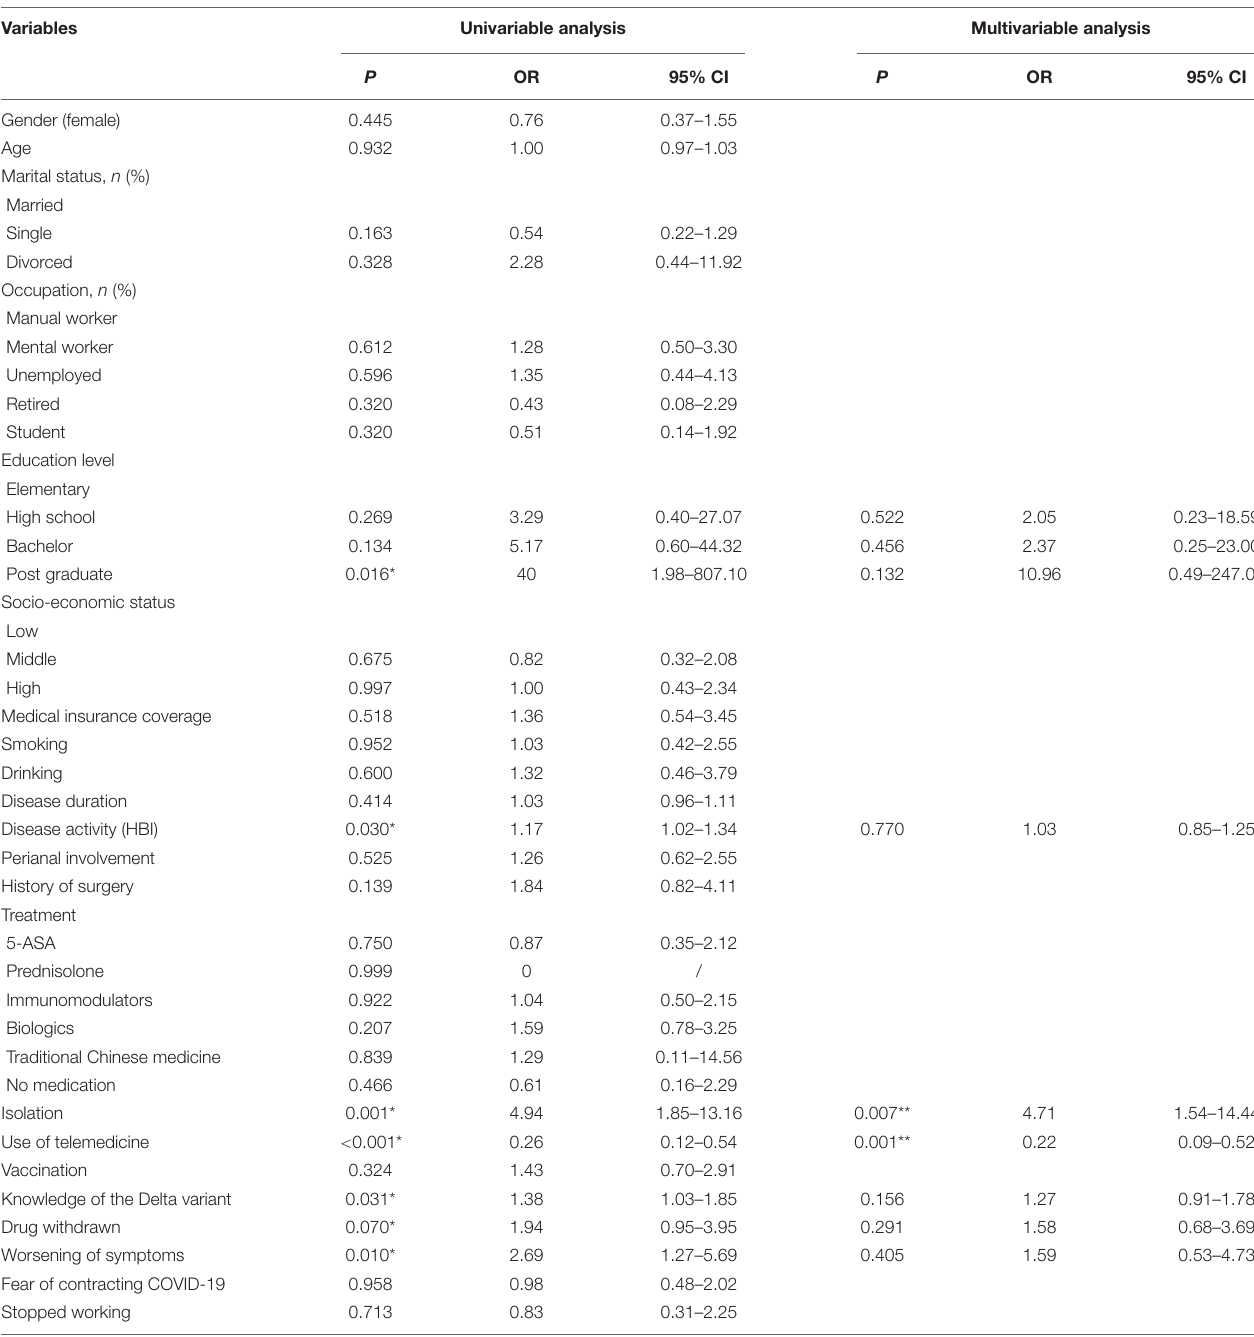
TABLE 4 | Factors associated with elevated